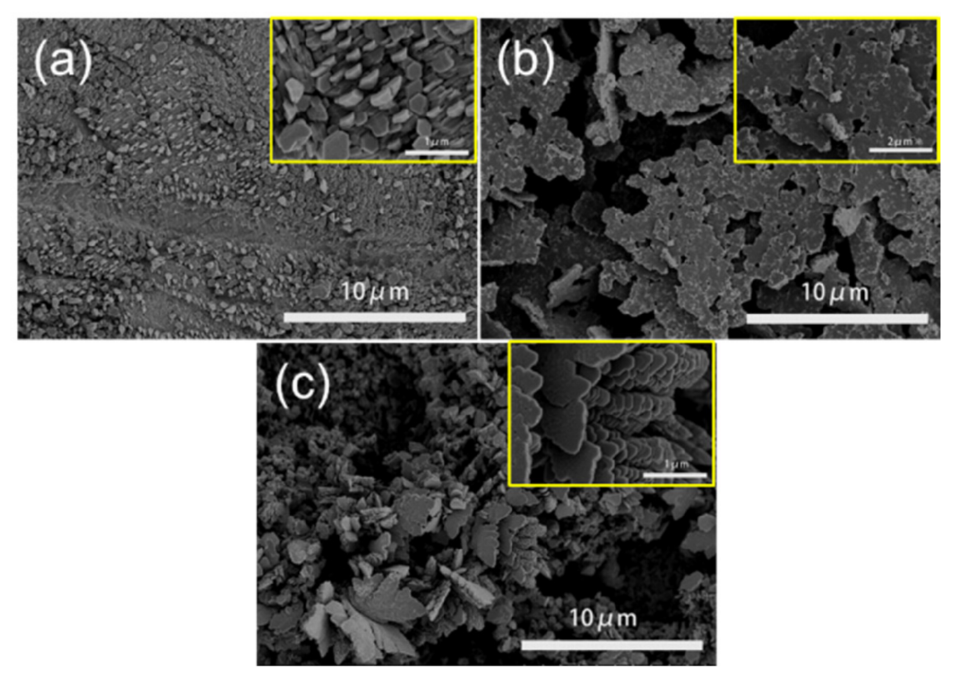
Figure 4. SEM images of representative Zn electrodes after reaction: ( a ) Zn foil electrode, ( b ) Zn-N 2 electrode, ( c ) Zn-CO 2